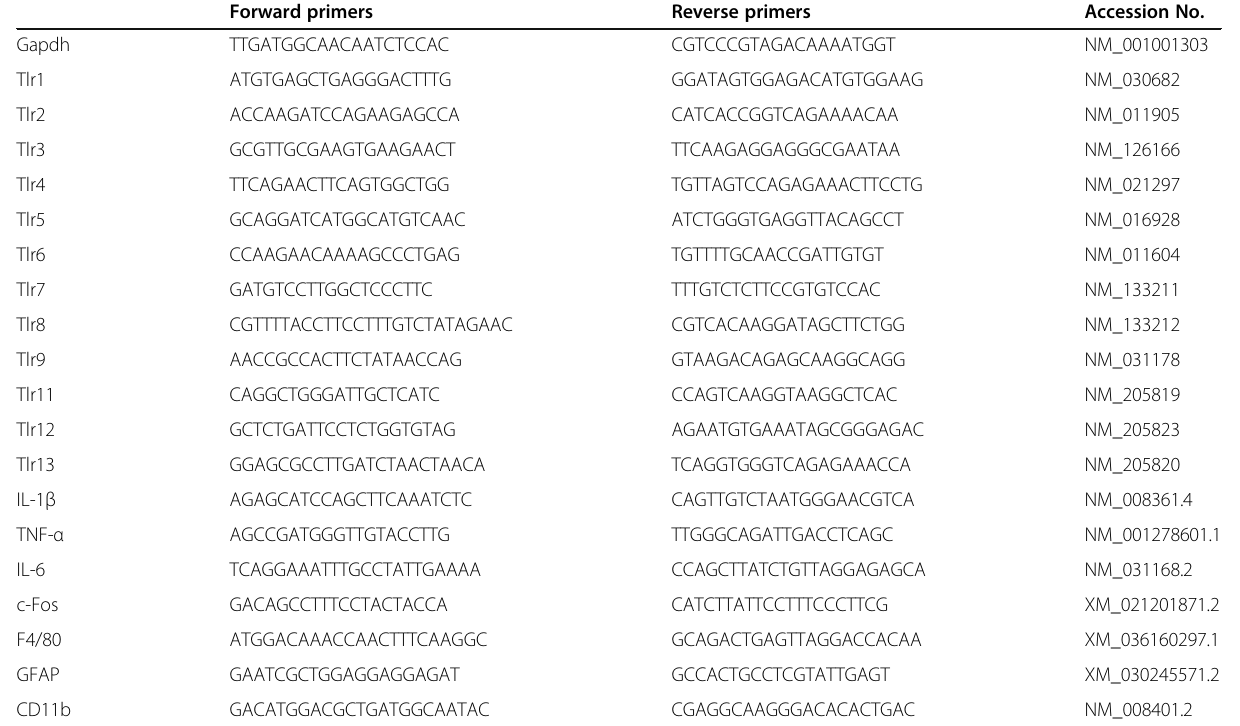
Table 2 The primers used in RT-qPCR Forward primers Reverse